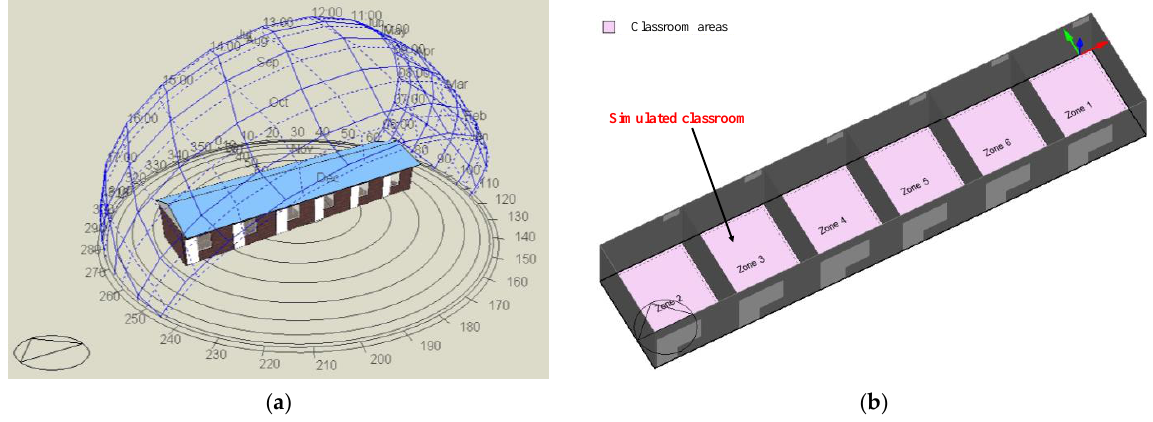
Figure 7. Three-dimensional view of the simulation school building model (S1): ( a ) sun path diagram and ( b ) zones. No urban setting was included in the model. Table 5. Building materials and their corresponding properties assigned for the model.